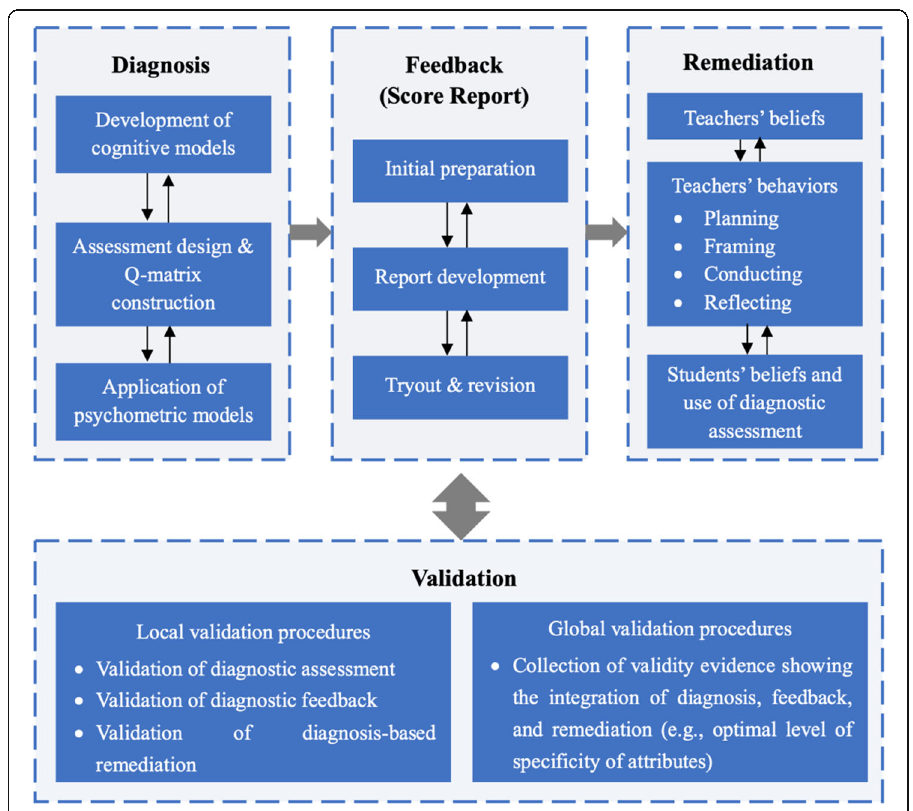
Fig. 1 An integrative framework of